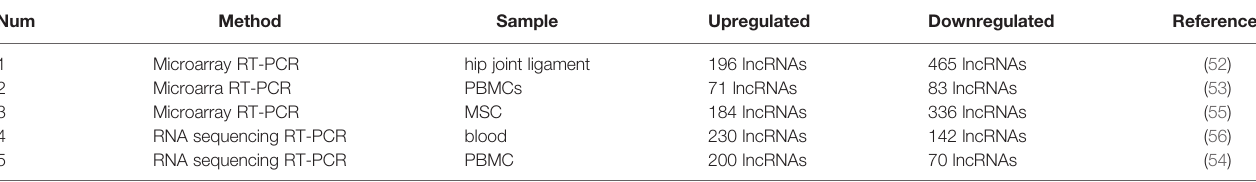
TABLE 1 | LncRNAs expression pro fi les in ankylosing spondylitis.